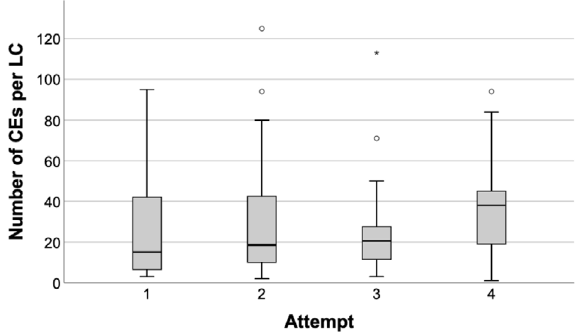
Figure 5. Number of CEs per LC in the total population broken down into attempts 1 – 4, per box plot n = 24 subjects with one LC per attempt (total 96 LCs with 24 LCs per boxplot).